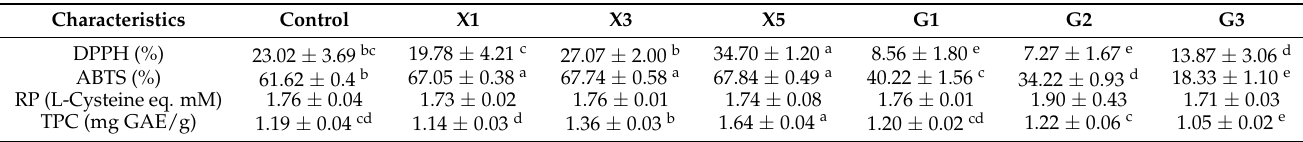
Table 6. Changes in antioxidant properties of soymilk-based banana-blueberry-puree by adding thickeners XanFlax and brand G.